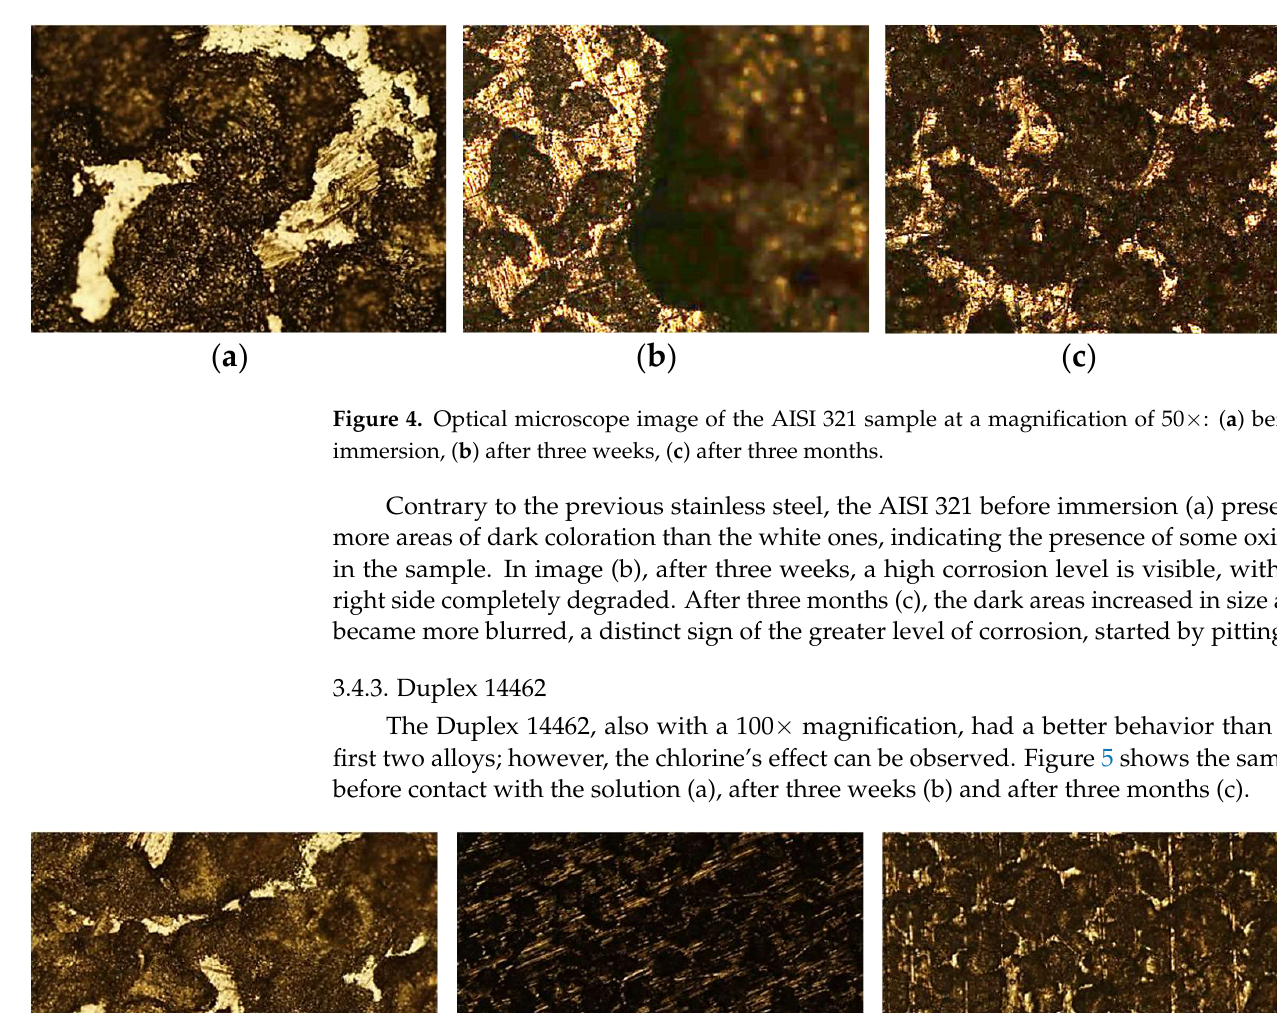
Figure 4. Optical microscope image of the AISI 321 sample at a magnification of 50×: ( a ) before immersion, ( b ) after three weeks, ( c ) after three months.